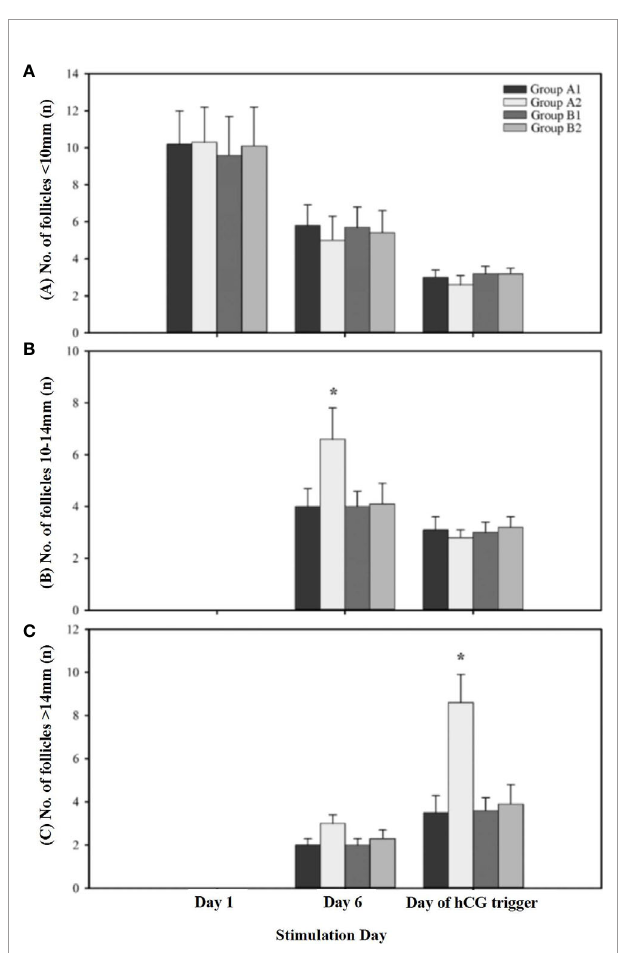
FIGURE 2 | The constitution of different diameters of follicles during ovarian stimulation. (A) Presents the number of follicles < 10mm on different stimulation day; (B) Presents the number of follicles 10-14mm on different stimulation day; (C) Presents the number of follicles > 14mm on different stimulation day. A1 indicates fi rst cycle of Group A; A2 indicates second cycle of Group A; B1 indicates fi rst cycle of Group B; B2 indicates second cycle of Group B. * indicates signi fi cant differences (P < 0.05) within treatment groups on the same stimulation